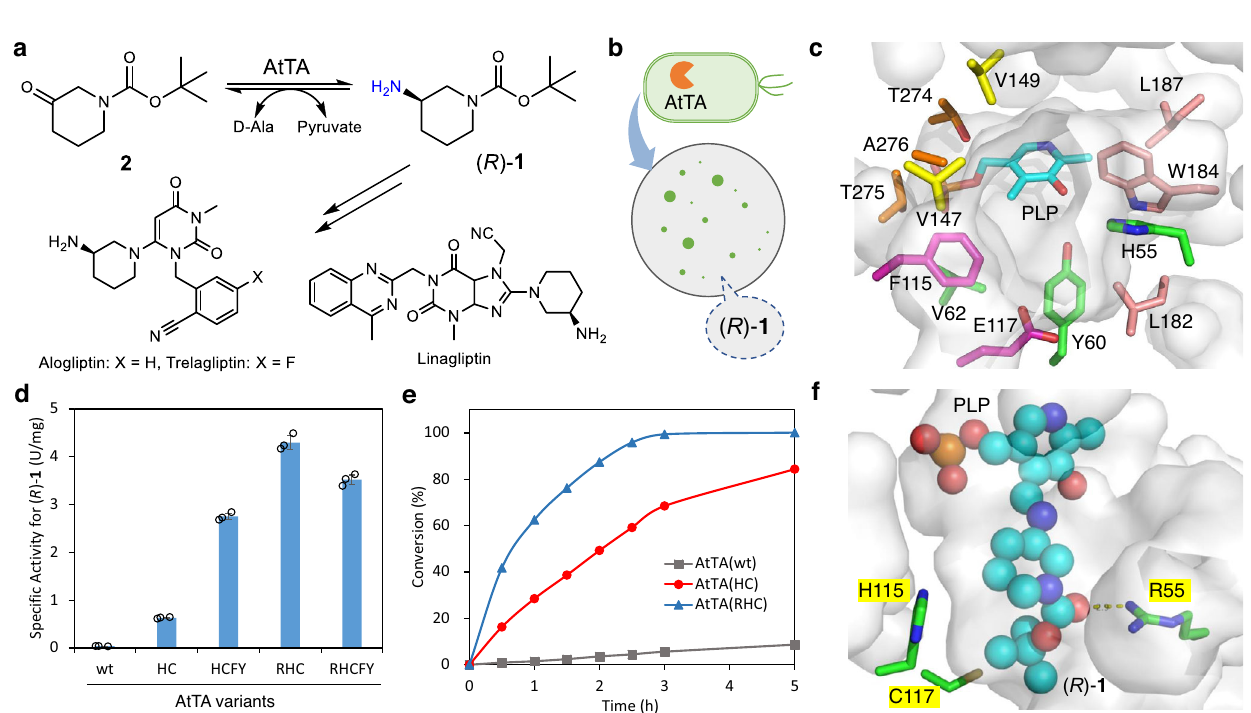
Fig. 2 | General procedure of the growth-based directed evolution system to improve amine-forming or converting enzymes. a Mutagenesis of the gene encoding the enzyme of interest cloned under a promoter with suitable strength. b E.coli hostcellsaretransformedwiththe genelibrary. c SelectionwithM9plates